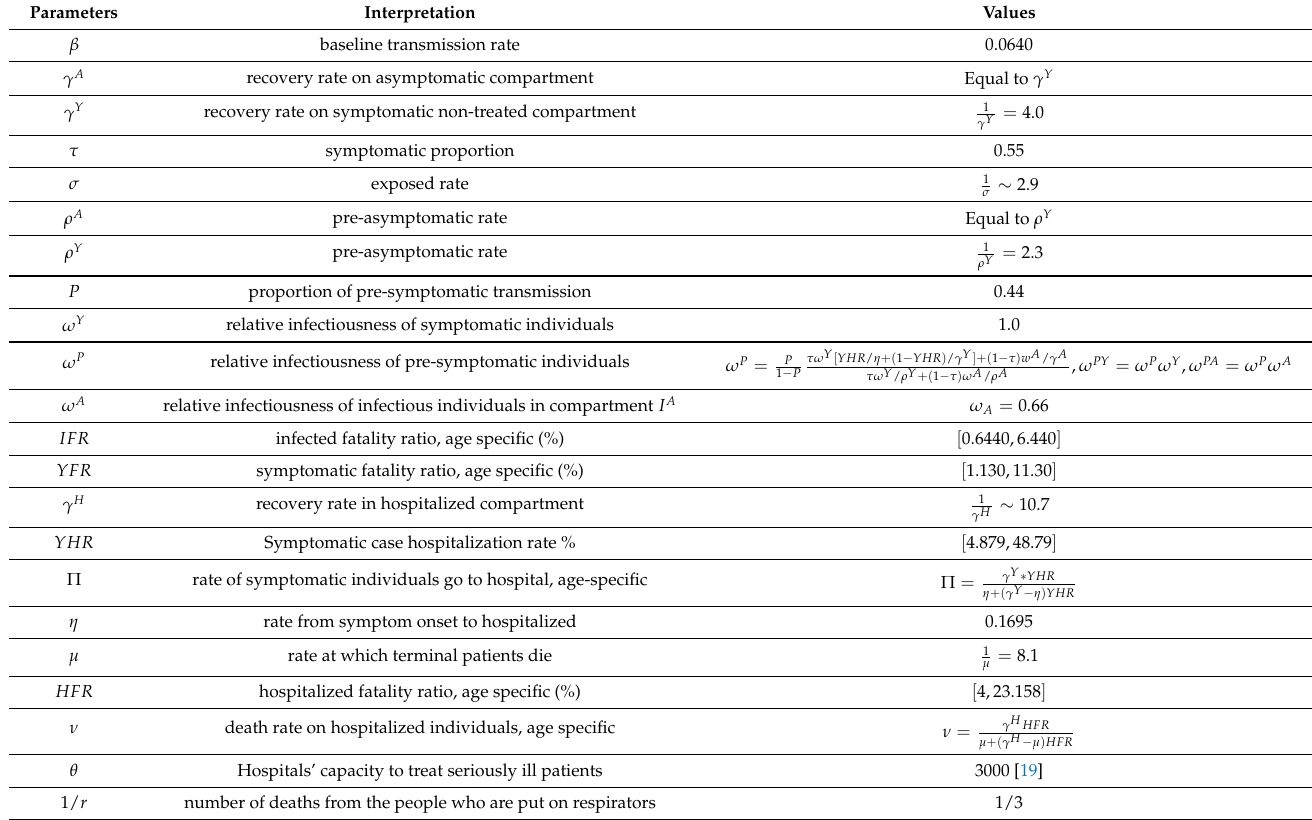
Figure 1. Multicompartment structure of COVID-19 transmission model (taken from [6]). The interpretation and numerical values of the model’s parameters are listed in Table 1. At t = 0, all compartment populations are assumed to be nonnegative, and, for t ≥ 0, the model has non-negative solutions contained in the feasible region Γ Table 1. Baseline parameters used in the model